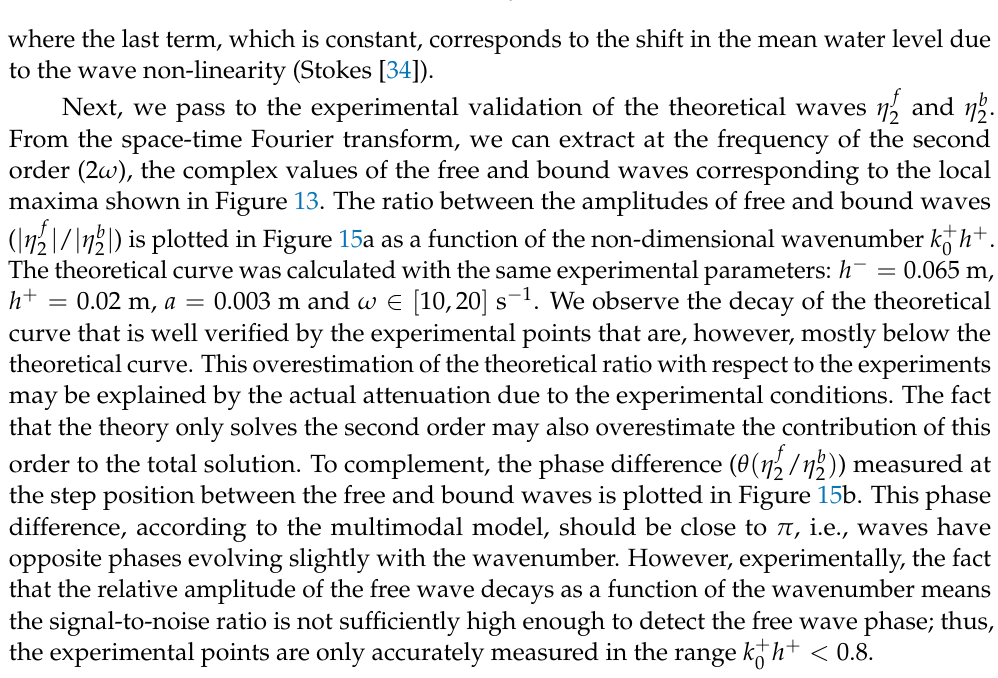
η f η b / . b ) Phase different between free η f η b / . ( b ) Phase different between 2 | 2 | | | 2 | 2 | | | ) . η b / ) η b / 2 2 | | 2 2 | |